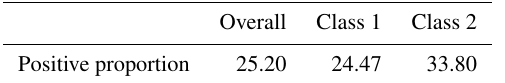
Table 3. Comparison of positive and negative proportions between three groups (unit